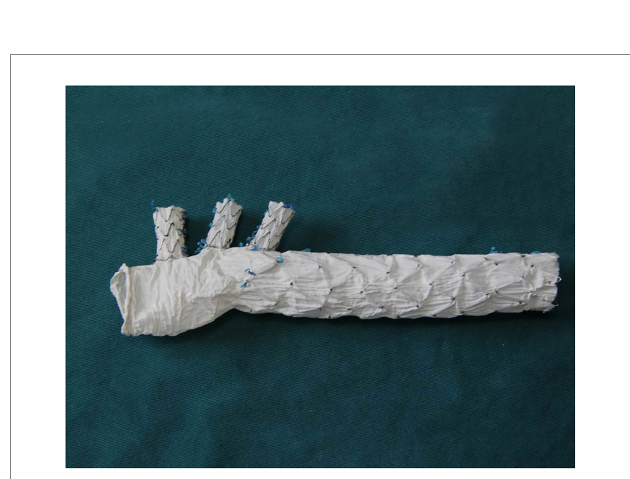
FIGURE 2 The modified triple-branched stent graft is comprised of a main graft and three sidearm